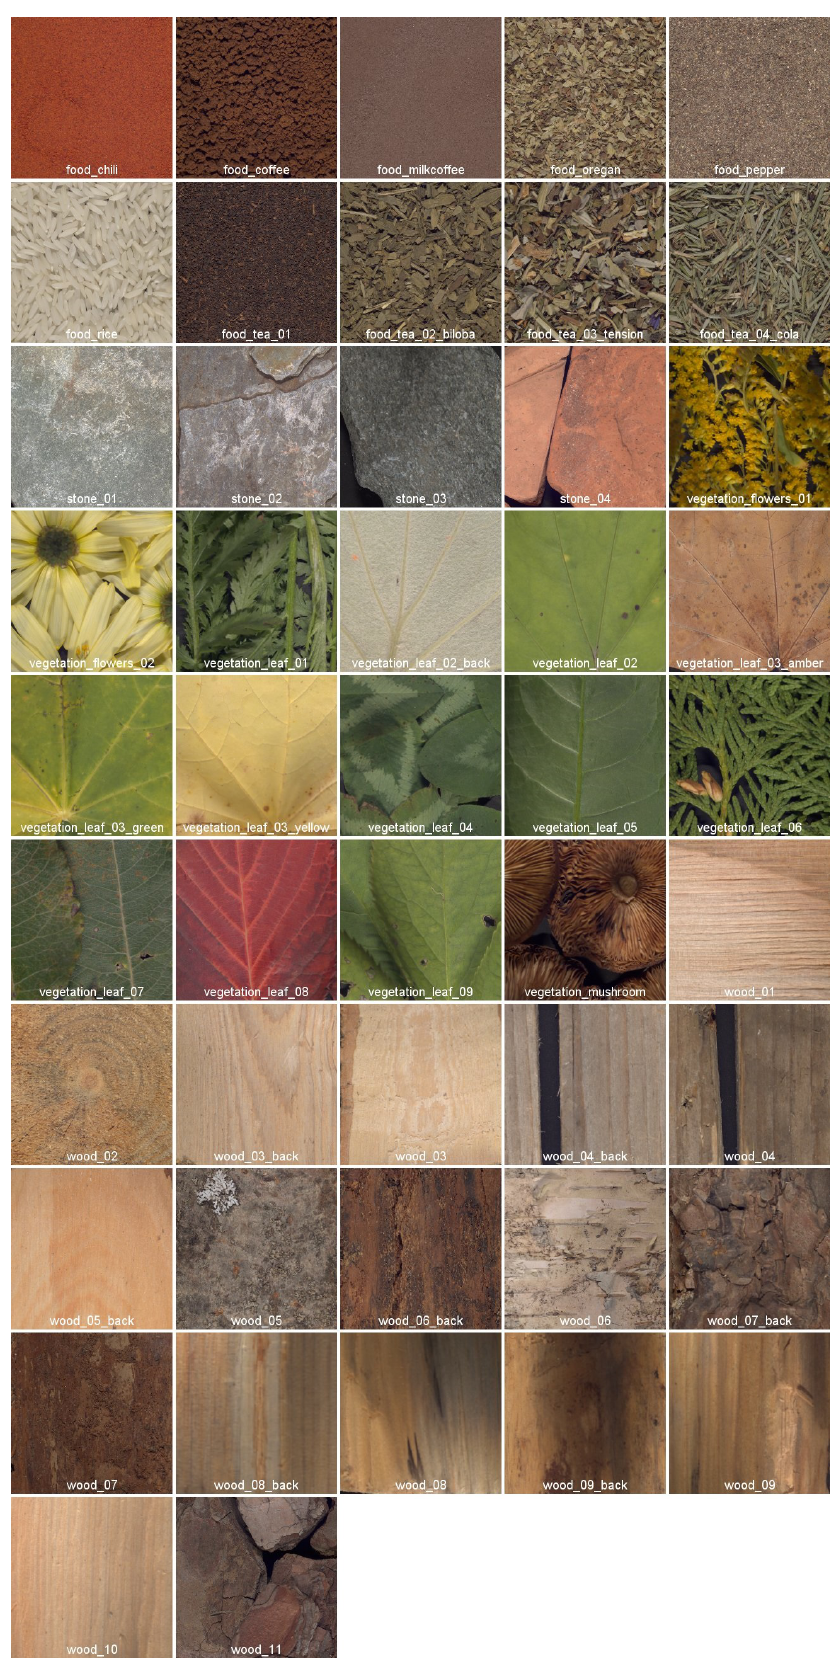
Figure 9. Reconstructed sRGB images from the food, stone, vegetation and wood categories of the